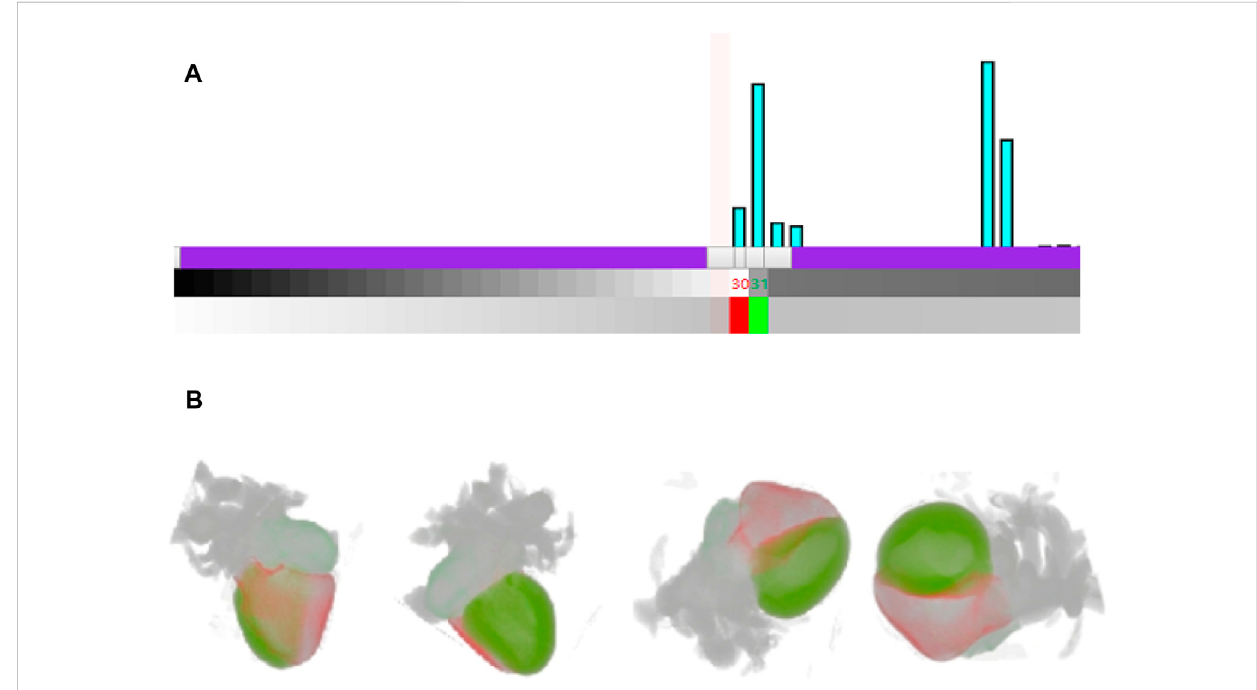
FIGURE 7 Interactive cardiac multi tissues rendering (A) . The interaction with cardiac modality histogram by adding control point and setting the color for the right ventricle and left ventricle (B) . Rendering result of the right ventricle and left ventricle from different